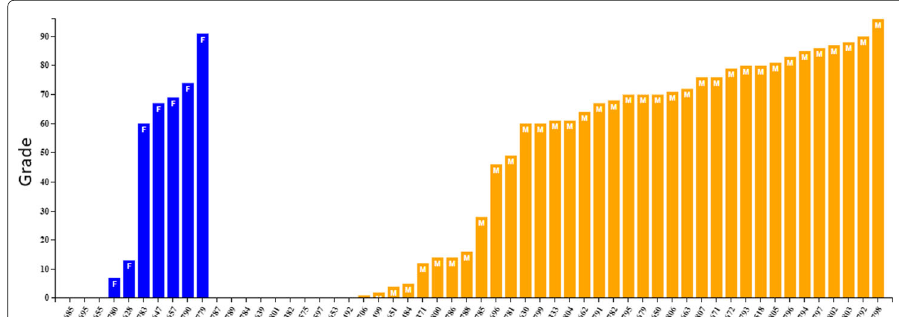
Fig. 18 Bar chart analysis of "Object-Oriented Programming" subject in 2014/01 semester. This Bar chart is presented when users click a cell on Heatmap Matrix visualization of Gender vs. Grade. Female students are shown by blue bars and male students by yellow